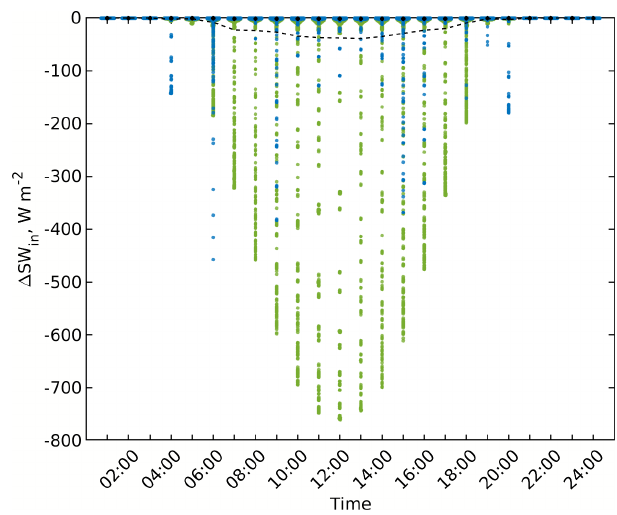
Figure 7. Changes in the received SW irradiance within the focus domain of the simple urban configuration when considering vegeta- tion interaction with SW solar radiation (RTM_03) compared to the RTM_02. Violin, mean, and median colours are used in the same way as those in Fig.